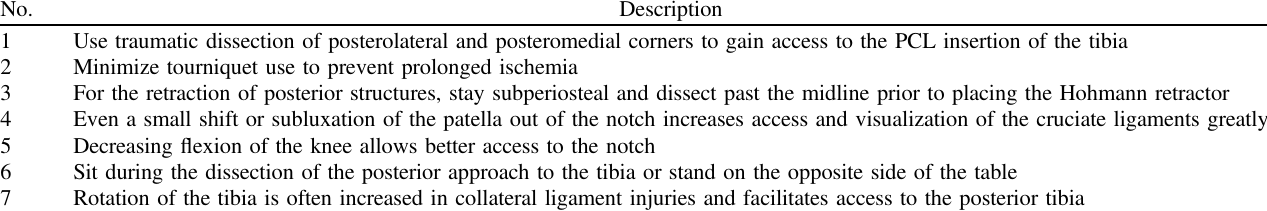
Table 2. Key points for open cruciate procedures. No. Description